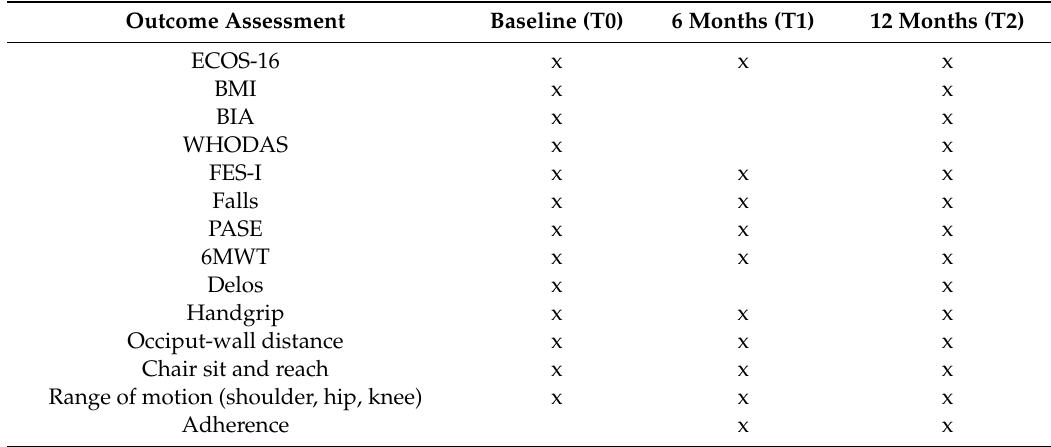
Table 2. Outcome